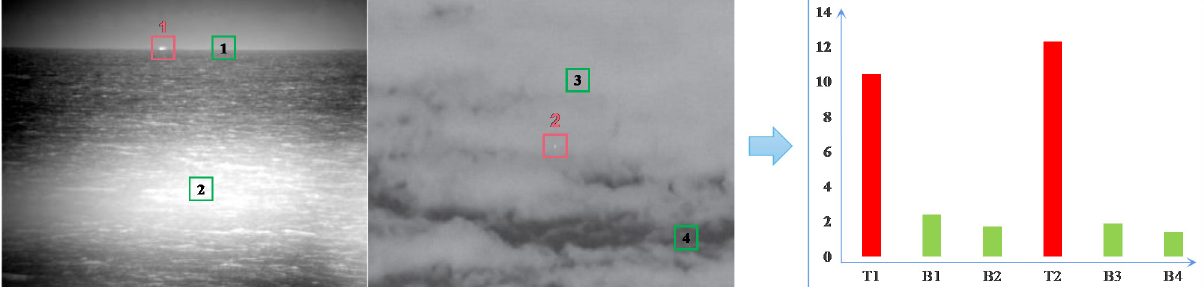
Figure 2. Typical scene of IR dim target detection and the LAGDM value of the corresponding area. The red box is the target (T), and the green box is the background interference (B).